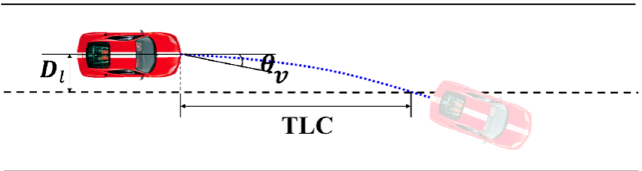
Figure 3. Illustration of time-to-line-crossing (TLC). Black dotted lines and solid lines represent lane lines, and the blue dotted line is vehicle trajectory.